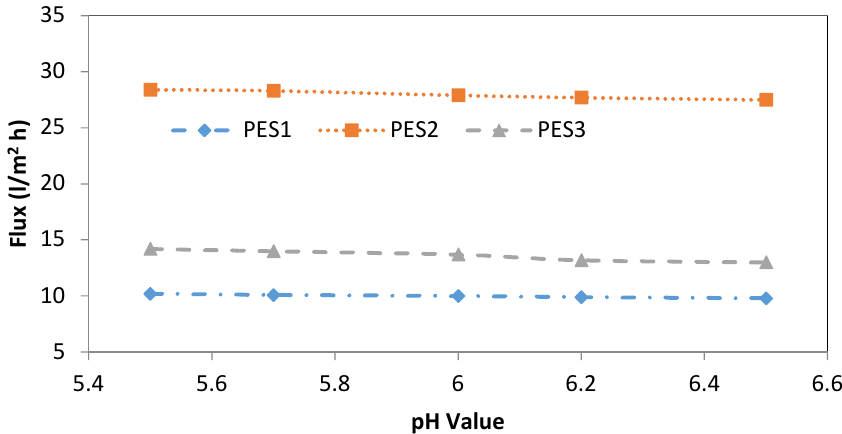
Figure 4. Effect of feed pH value on final permeate flux of PES1, PES2, and PES3 membranes, (experimental conditions: Cd 2+ concentration of 100 ppm, transmembrane pressure of 1 bar).